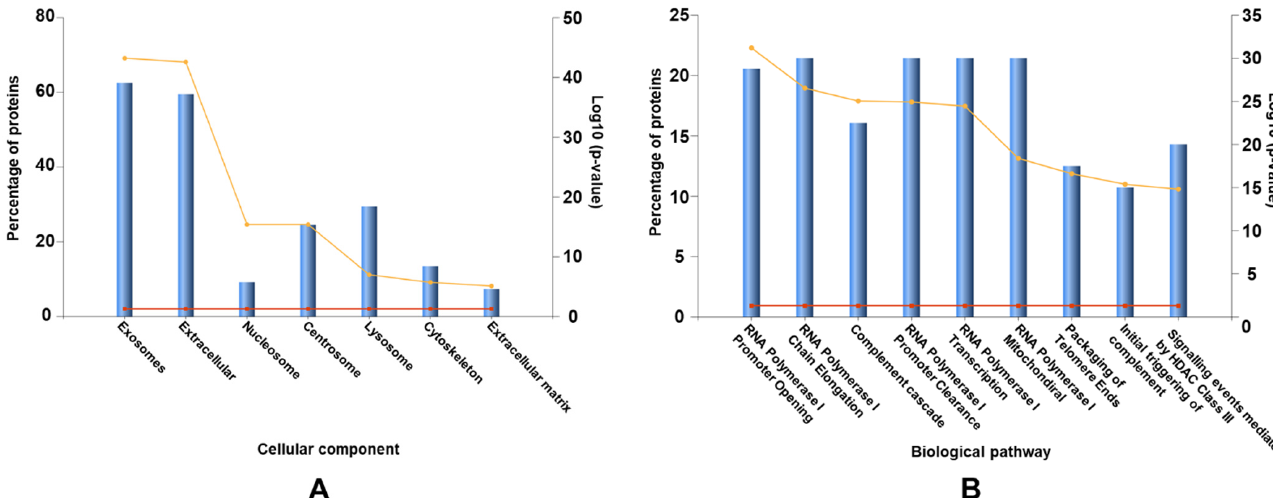
Figure 3. Cellular and biological pathways that are over-represented among extracellular vesicle associated proteins. EVs/exosomes were the most enriched cellular components ( A ) whereas various forms of RNA processing were the most enriched biological pathways ( B ). The x axis on the left represents the percentage of proteins (blue bars) identified in our data set that are expressed or involved in each category. The x axis on the right represents the significance of this as log 10 ( p -value) (yellow line). The red line represents the significance at p = 0.05 as a